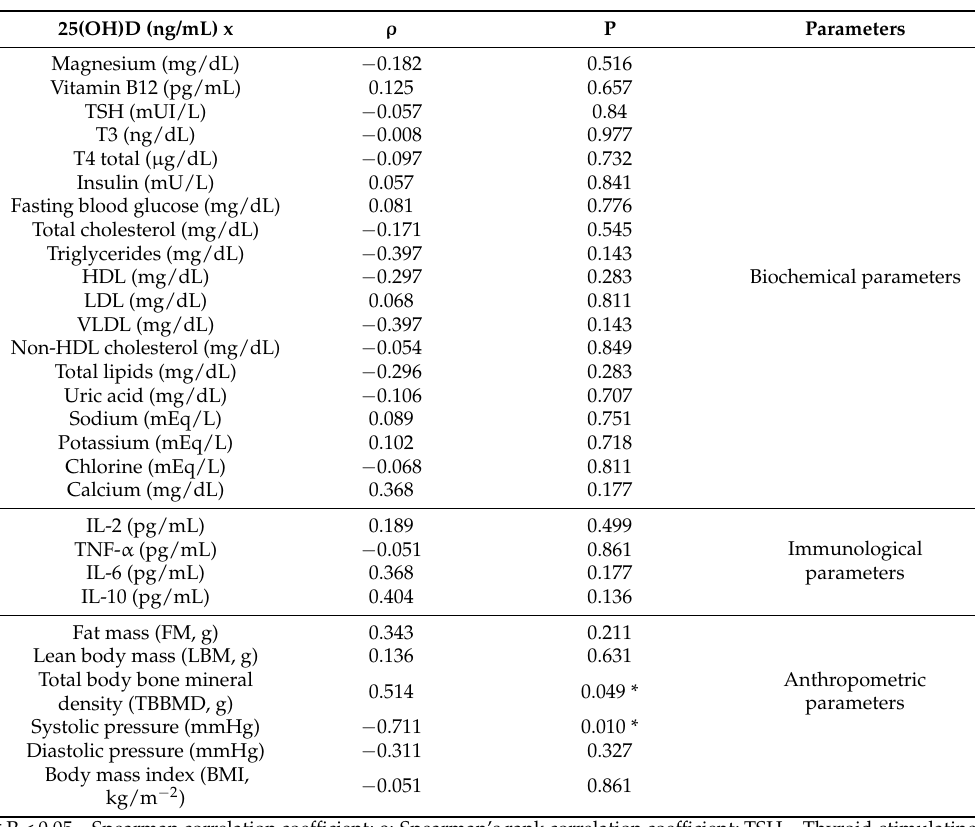
Table 1. Correlation between vitamin D [25(OH)D] serum levels and biochemical, immunological, and anthropometric